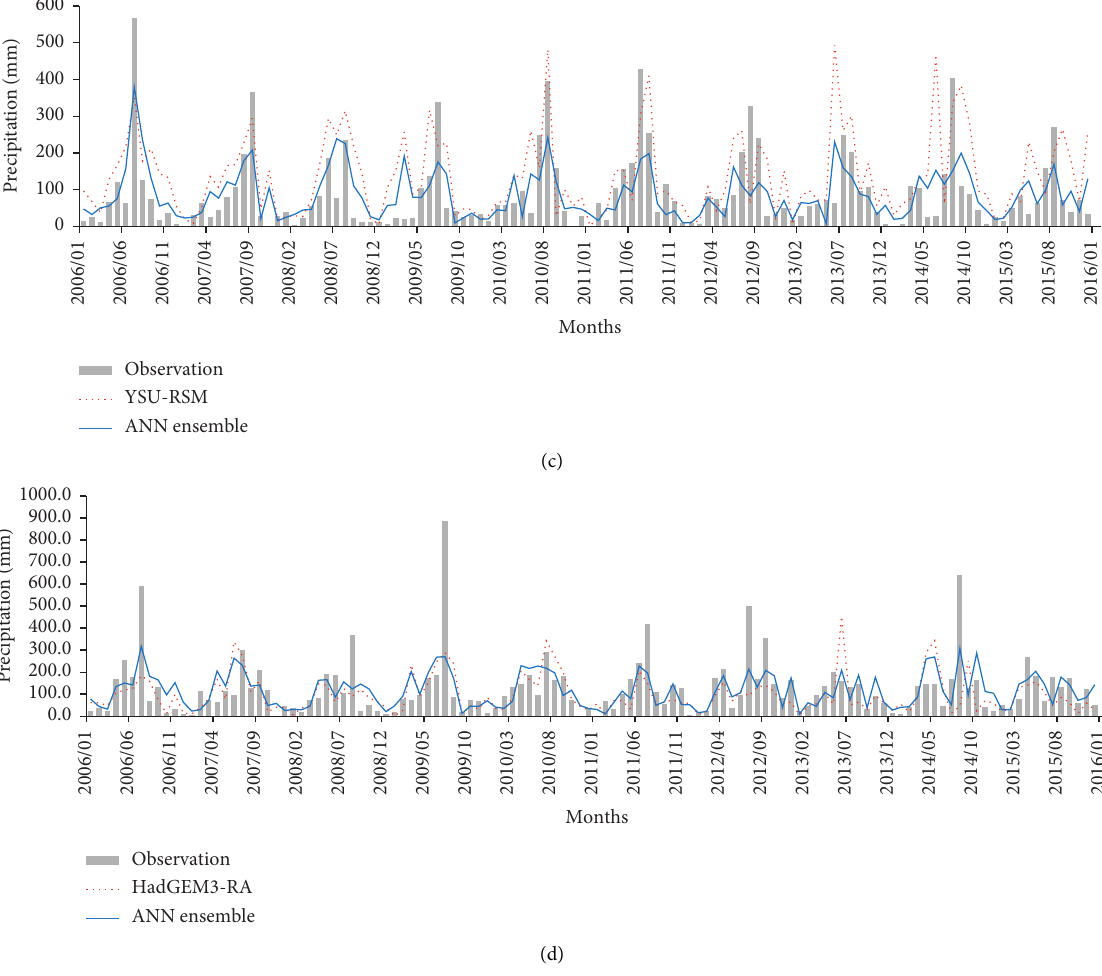
Figure 5: Precipitation comparison between ANN simulation and RCM with observed value: (a) Seoul, (b) Daejeon, (c) Daegu, and (d) Busan. Table 5: Basic precipitation comparison (unit: